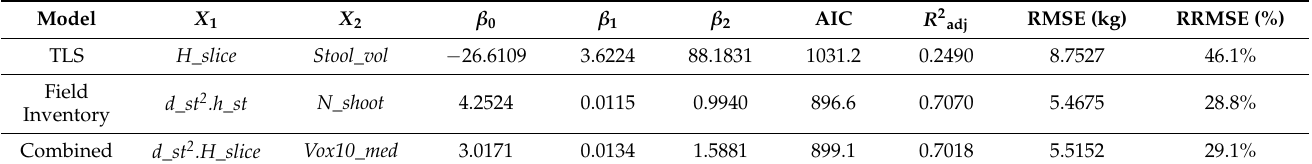
Table 5. Parameter estimates and goodness-of-fit statistics for the three fitted models (Equation (2)) for individual stool